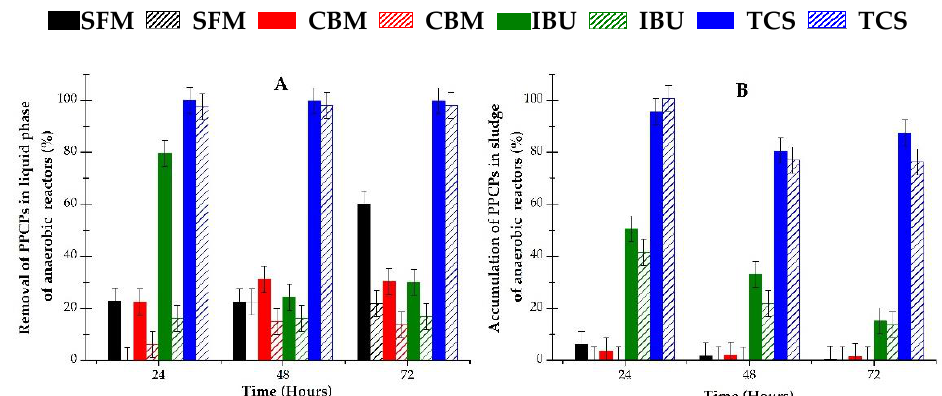
Figure 2. Removal of selected pollutants in aqueous media and their accumulation into the sludge of anaerobic reactors: ( A ) liquid fraction; ( B ) solid fraction (sludge). Filled bars correspond to individual contaminant in reactors; hatched bars correspond to mixture of pollutants in reactor.